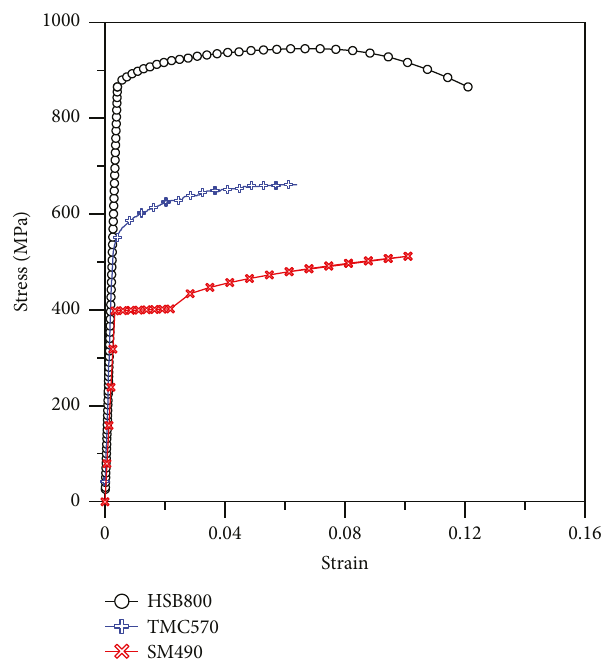
Figure 2: Stress-strain relation of steel.